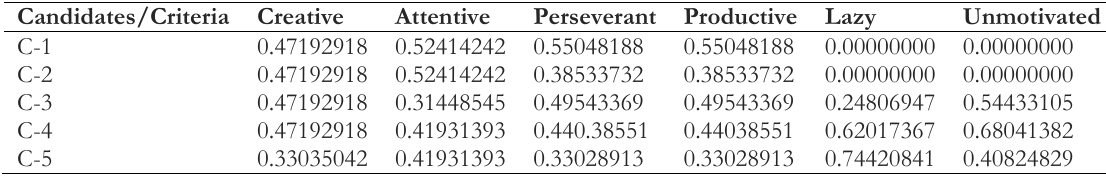
Table 9. Results of the normalized decision matrix.